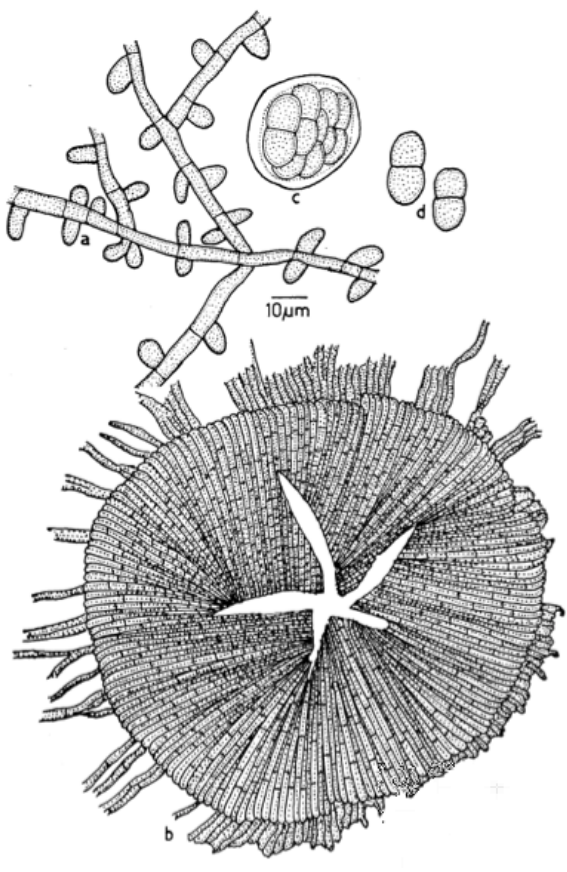
Figure 133. Asterina betonicae a - Appressorium; b - Thyriothecium; c - Ascus; d -